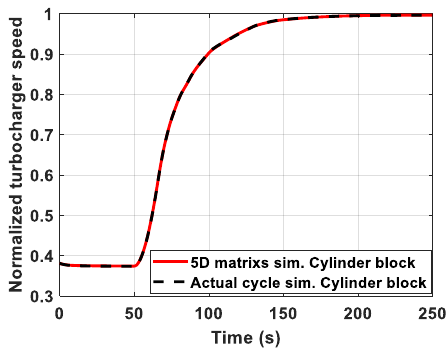
Figure 14. TC speed time history.